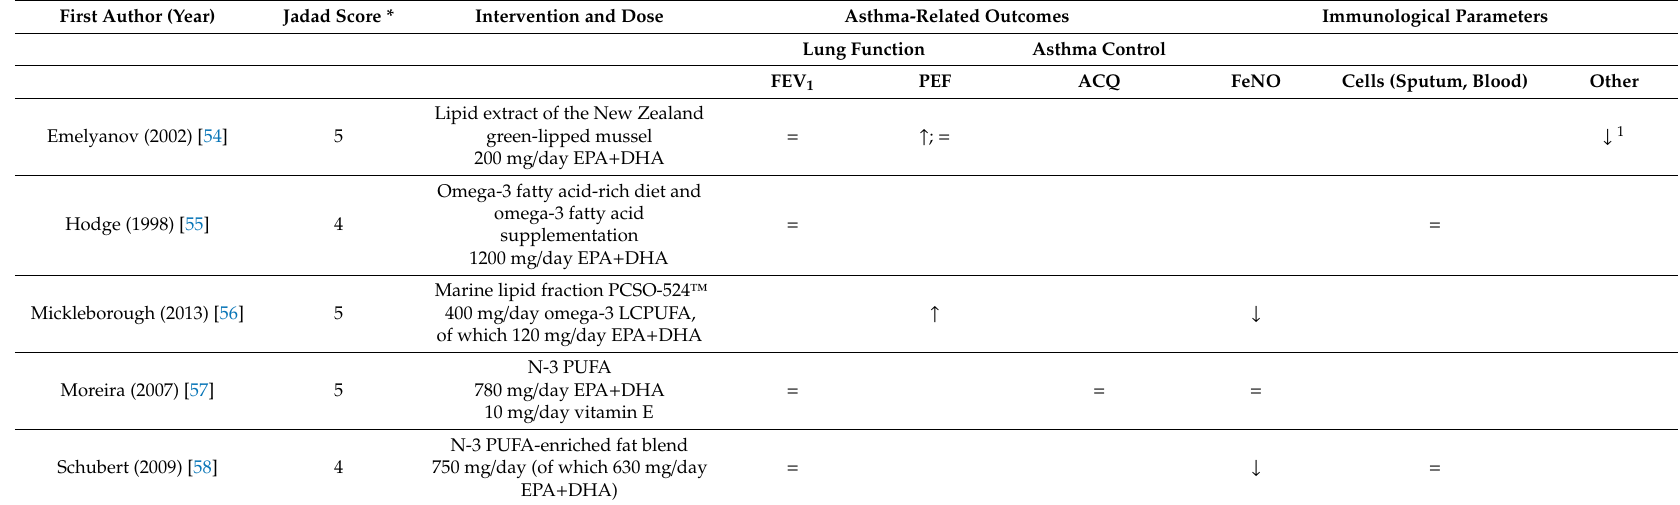
Table 6. Changes in asthma-related outcomes and immunological parameters as compared to the control group for the omega-3 long-chain polyunsaturated fatty acids (LCPUFA)